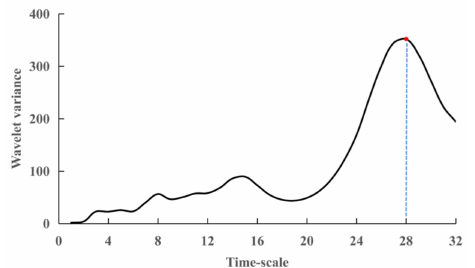
Figure 3. Rainfall wavelet variogram.